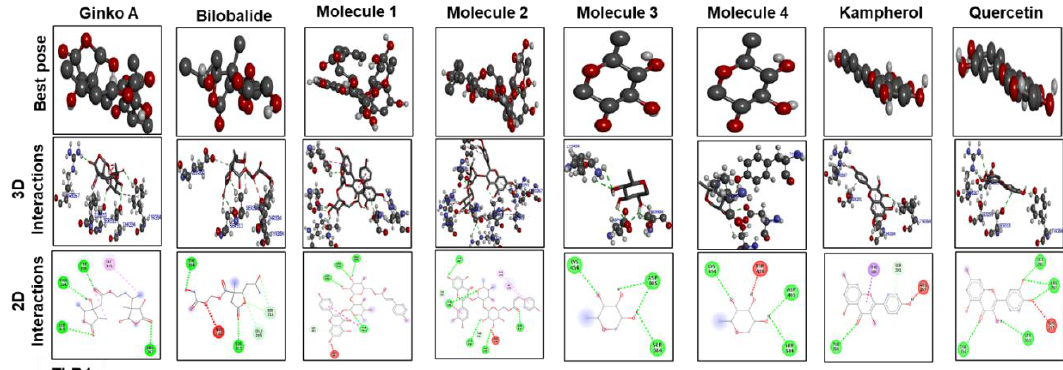
Figure 10. The different panels represent the docking analysis and best pose of ginkgolide A, bilobalide, 3-O-(2 (cid:48) -O-(6 (cid:48) -O-(p-coumaroyl)- β - d -glucosyl)- α - l -rhamnosyl) kaempferol (Molecule 1), 3-O-(2 (cid:48) -O-(6 (cid:48) -O-(p-coumaroyl)- β - d -glucosyl)- α - l -rhamnosyl) quercetin (Molecule 2), 3-O-(2 (cid:48) -O,6 (cid:48) -O-bis( α - l -rhamnosyl)- β - d -glucosyl) kaempferol (Molecule 3), 3-O-(2 (cid:48) -O,6 (cid:48) -O-bis( α - l -rhamnosyl)- β - d -glucosyl) quercetin (Molecule 4), quercetin, and kaempferol, after docking with TLR4. Both 2D and 3D shapes of the drug-receptor complex were visualized by DSV.